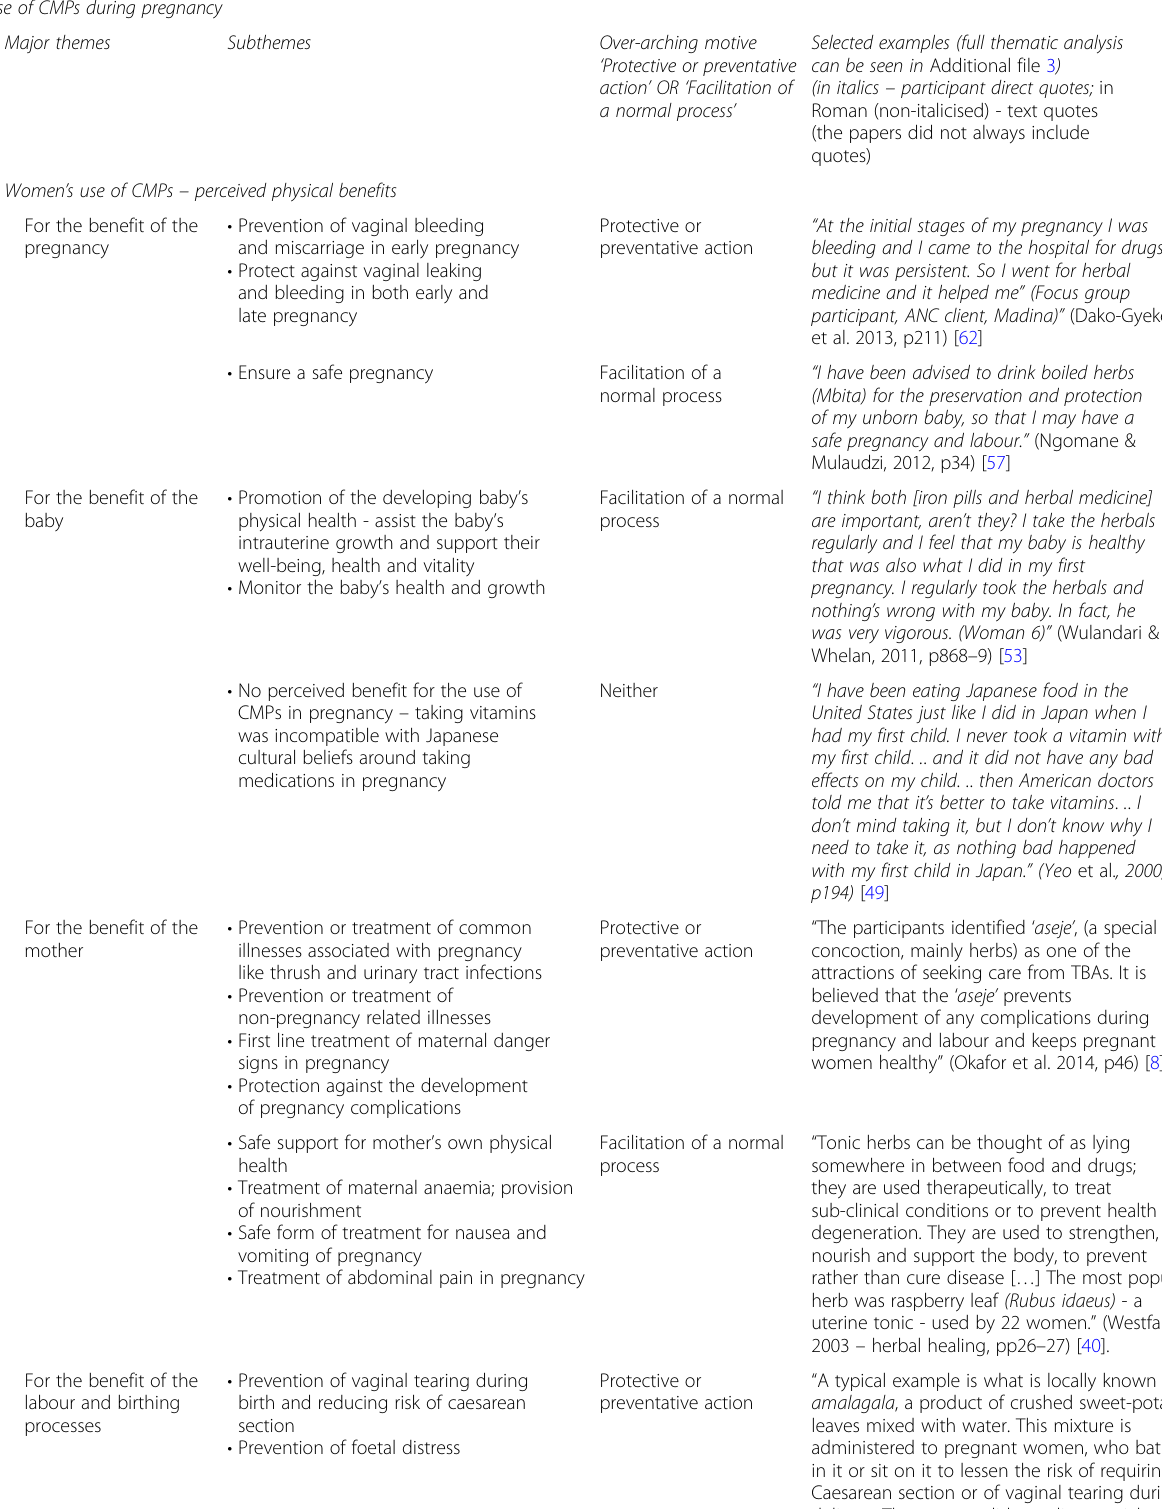
Table 3 Thematic analysis: women ’ s use of CMPs in pregnancy and lactation and perceived benefits Use of CMPs during